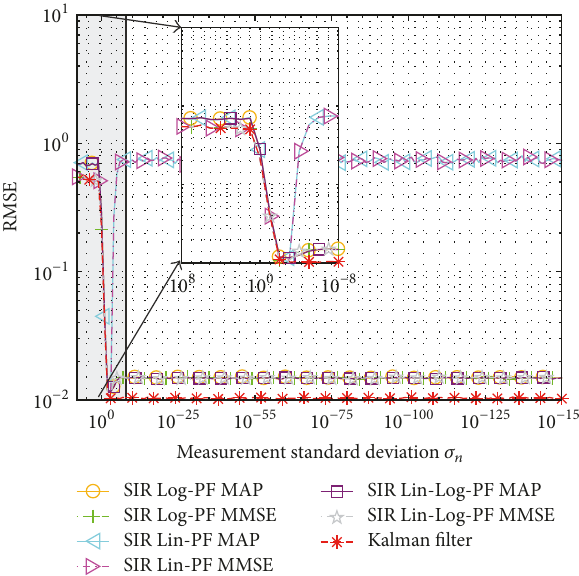
Figure1:PerformanceevaluationoftheSIRLog-PF,SIRLin-PF,SIR Lin-Log-PF, and KF by the RMSE versus a decreasing measurement standard deviation 𝜎 𝑛